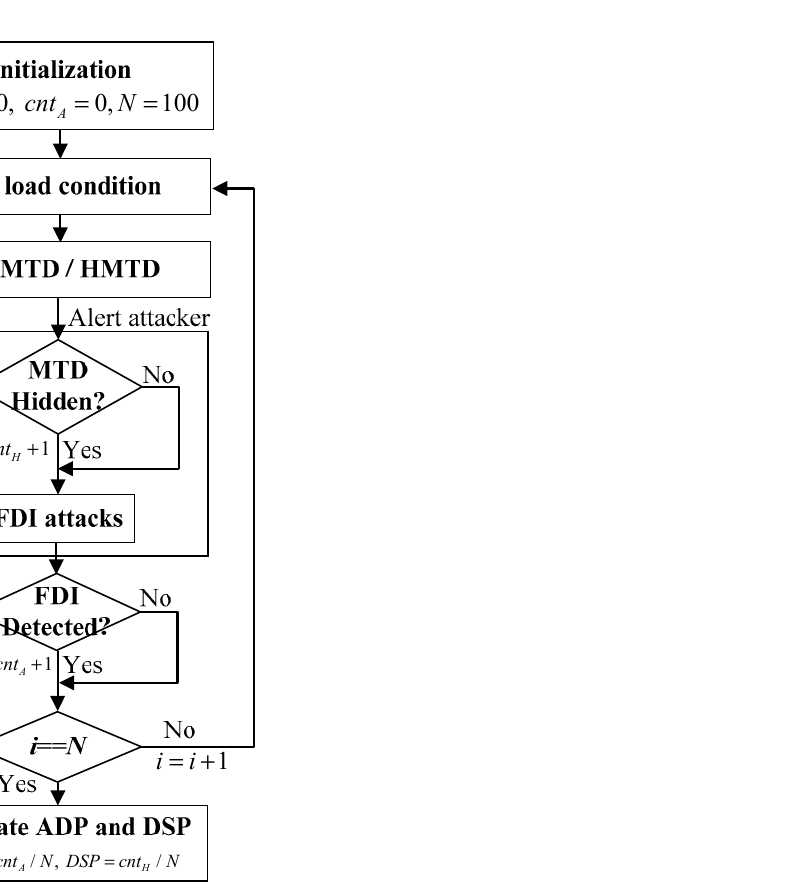
Figure 4. Flowchart of HMTD against alert attackers regarding the attack detection probability and defense stealthy probability.